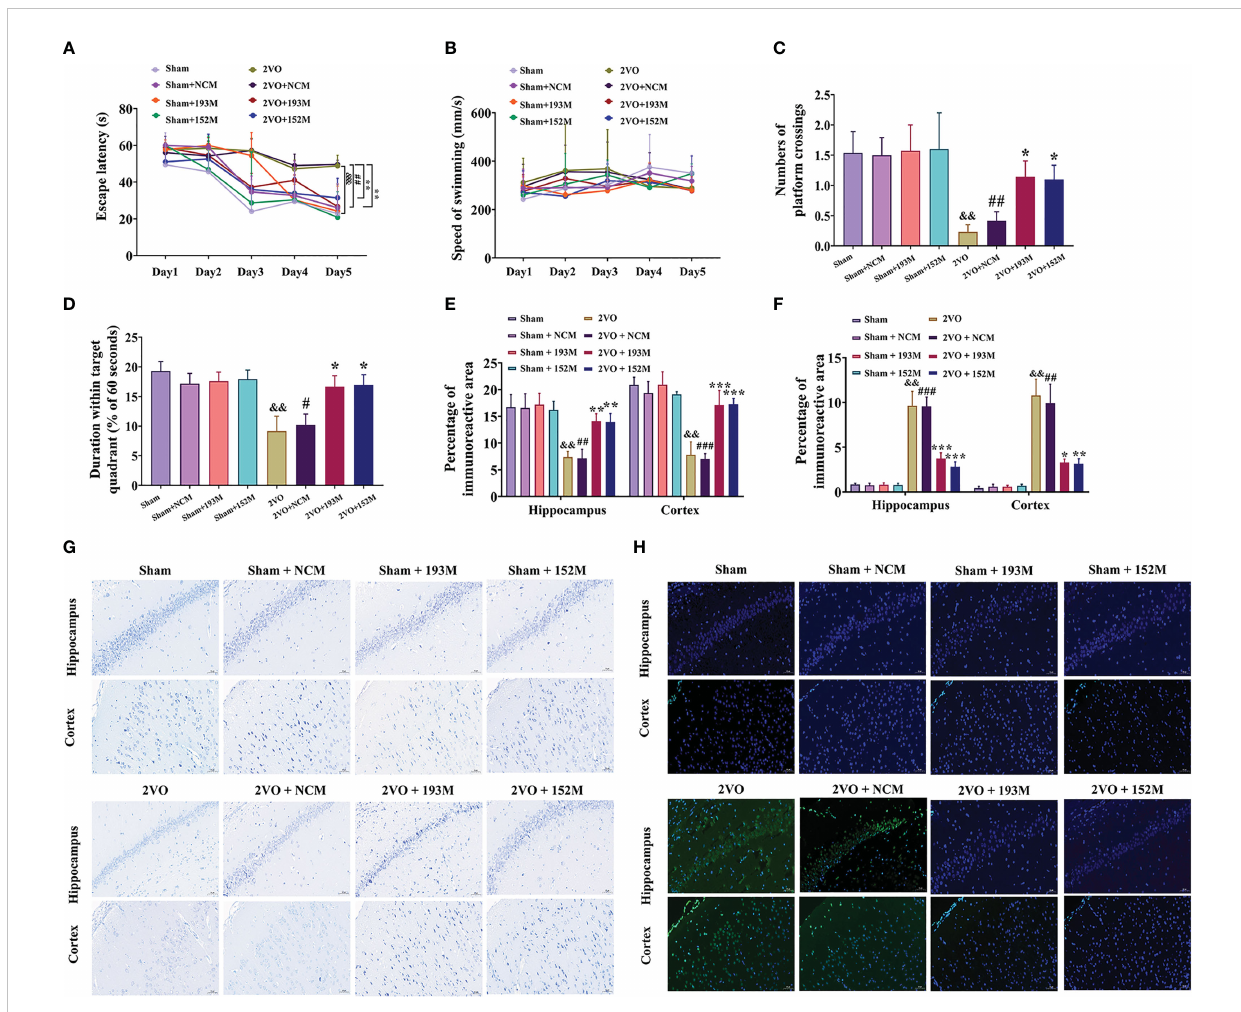
FIGURE 4 Effects of miR-193b-3p and miR-152-3p on cognitive decline and neurodegeneration in 2VO rats. (A) Comparison of the latency to fi nd the platform during the fi ve training days for the Morris water maze test ( n = 8). (B) Swimming speed during the fi ve training days ( n = 8). (C) Percentage of time spent in the target quadrant in the probe test ( n = 8). (D) Number of crossings where the platform was previously located in the probe test ( n = 8). (E) Quantitative analysis of immunoreactivity of Nissl staining in the cerebral cortex and hippocampus of 2VO rats ( n = 3). (F) Quantitative analysis of immunoreactivity of TUNEL staining in the cerebral cortex and hippocampus of 2VO rats ( n = 3). (G) Representative images of Nissl-stained cortical and hippocampal neurons ( n = 3). Scale bar = 50 m m. (H) Representative images of TUNEL-stained cortical and hippocampal neurons ( n = 3). Scale bar = 50 m m. Results represent the mean ± SD, && P <0.01, &&& P <0.001 vs. sham, # P <0.05, ## P <0.01, ### P <0.001 vs. sham+NCM, * P <0.05, ** P <0.01, *** P <0.001 vs.